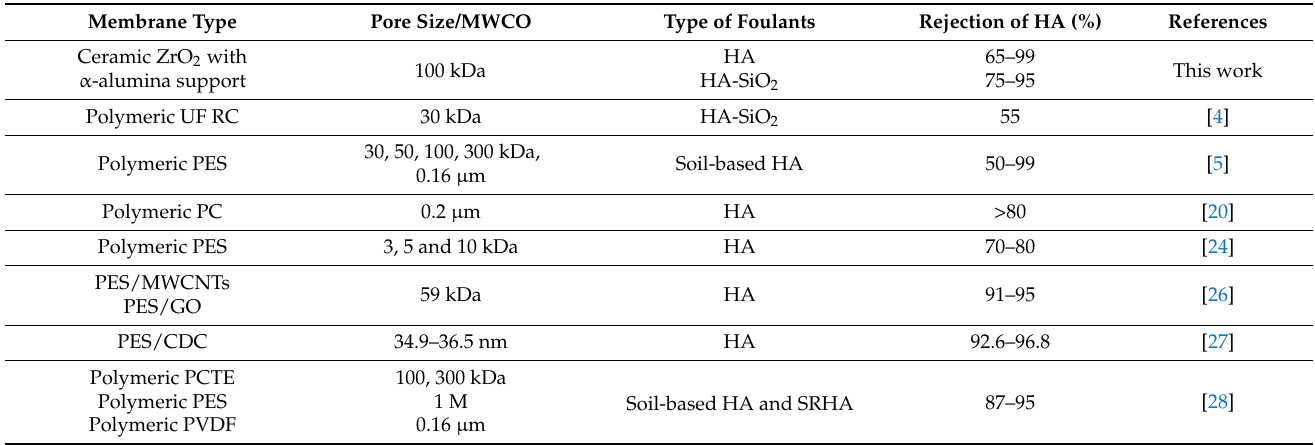
Table 1. Review of investigated studies on humic acid removal.